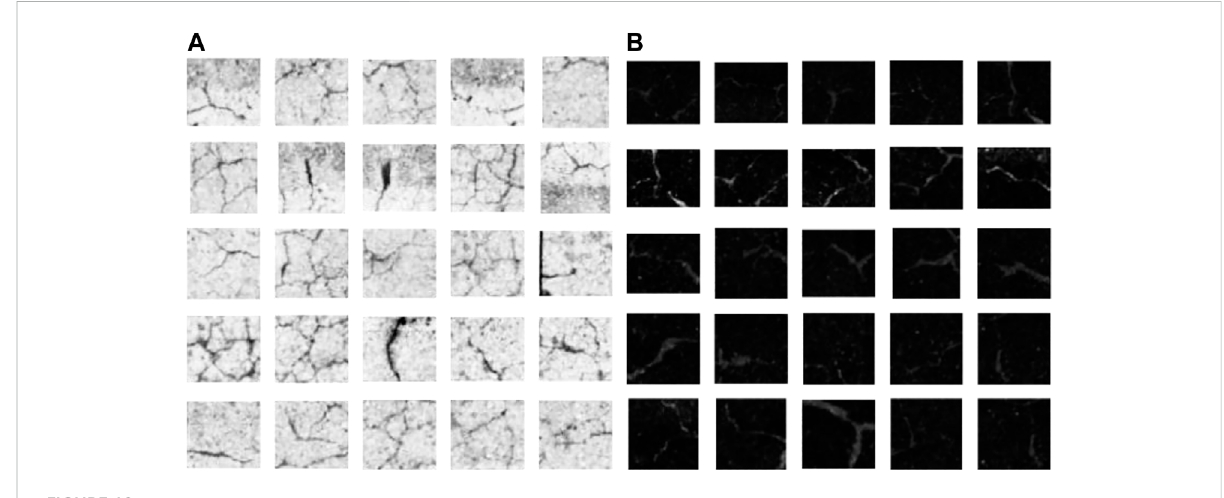
FIGURE 10 Images after color tone correction. (A) Crack. (B) Free lime.